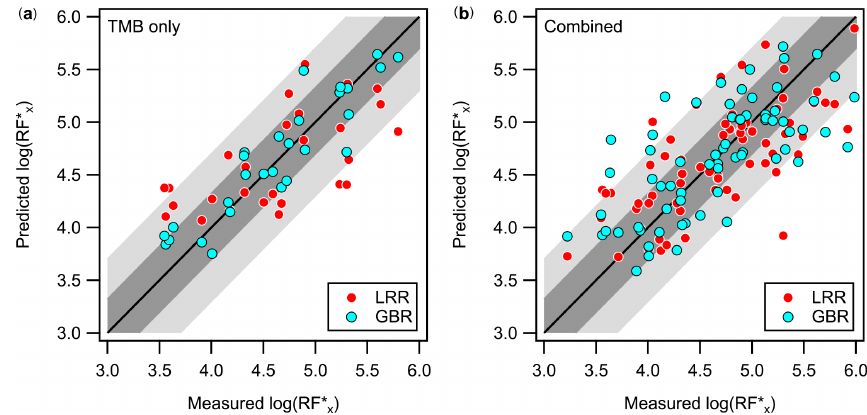
Figure 4. Comparison of the predicted and measured log of RF ∗ x values using linear ridge regression (LRR) and gradient boosting regression (GBR) for (a) the TMB system only or for (b) all three VOC systems combined, where the VOC precursor identity was one-hot encoded and included as one of the features. The 1-to-1 line is shown in solid black. The lighter- and darker-shaded regions represent deviations of a factor of 20 and 5 from the 1-to-1 line, respectively. Model accuracies (see Eq. S21) are approximately 0.83 for GBR and 0.40 for LRR in (a) and 0.52 for GBR and 0.50 for LRR in (b) . See Sect. 7 and Fig. S9 in the Supplement for details on feature selection and model validation.